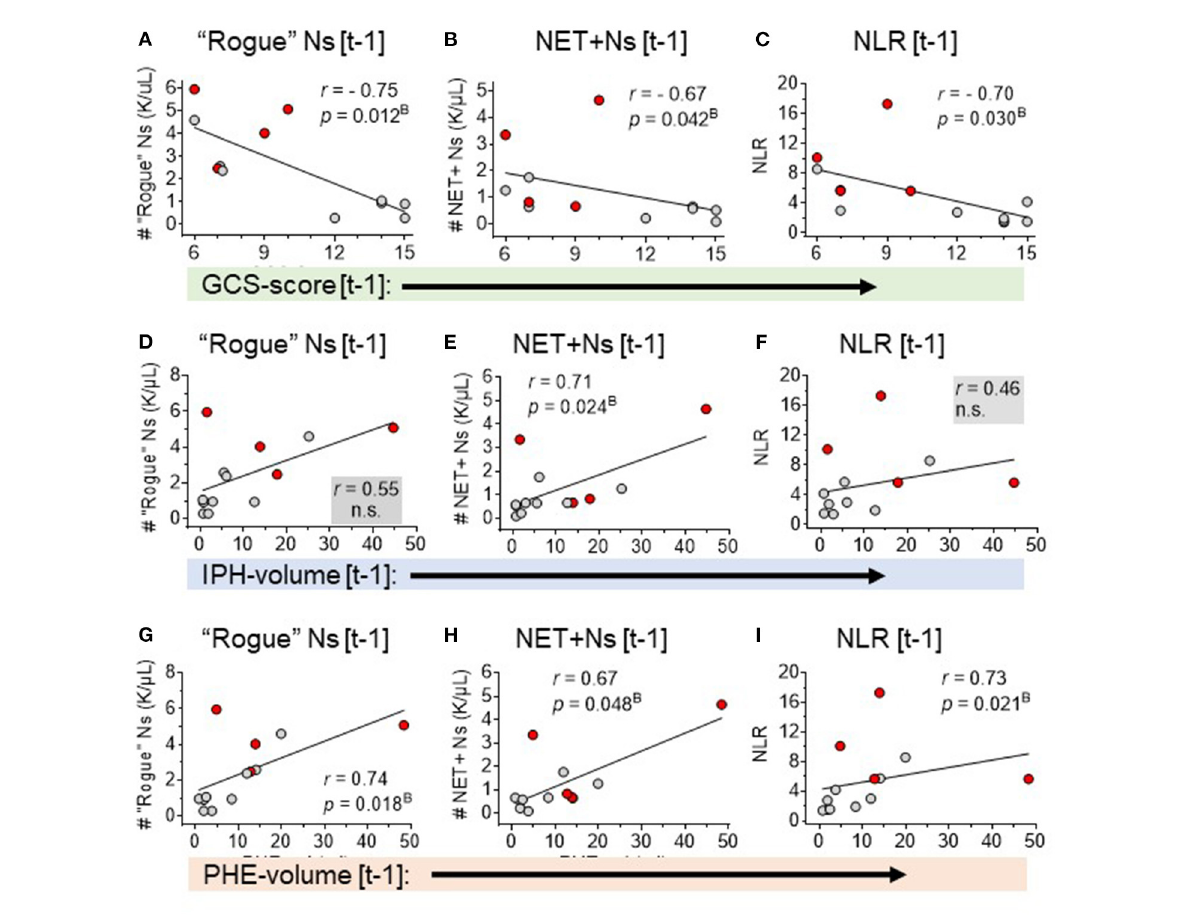
FIGURE2 Spearman rank correlation analyses of three neutrophil-based markers with sICH severity: GCS-score, IPH-volume, and PHE-volume. Correlation of GCS-score [t-1] with (A) DEspR + CD11b + neutrophil counts, K/ µ l (“rogue” Ns [t-1]). (B) NET-forming neutrophil counts, K/ µ l, (NET + Ns [t-1] and (C) neutrophil lymphocyte ratio (NLR). Correlation of IPH volume [t-1] with: (D) DEspR + CD11b + neutrophil counts, K/ µ l (“rogue” Ns [t-1]), (E) NET-forming neutrophil counts, K/ µ l (NET + Ns [t-1], and (F) neutrophil-lymphocyte ratio (NLR). Correlation of PHE-volume [t-1] with (G) DEspR + CD11b + neutrophil counts, K/ µ l (“rogue” Ns [t-1]), (H) NET-forming neutrophil counts, K/ µ l (NET + Ns [t-1]), and (I) neutrophil-lymphocyte ratio (NLR). All measurements were obtained on the same day ± 1-day [t-1] as the day of flow cytometry analysis; red • symbols represent sICH-subject nonsurvivors; gray • symbols mark values for sICH-subject survivors; r , Spearman rank correlation coefficient; p B , p -value with Bonferroni correction. ns, not